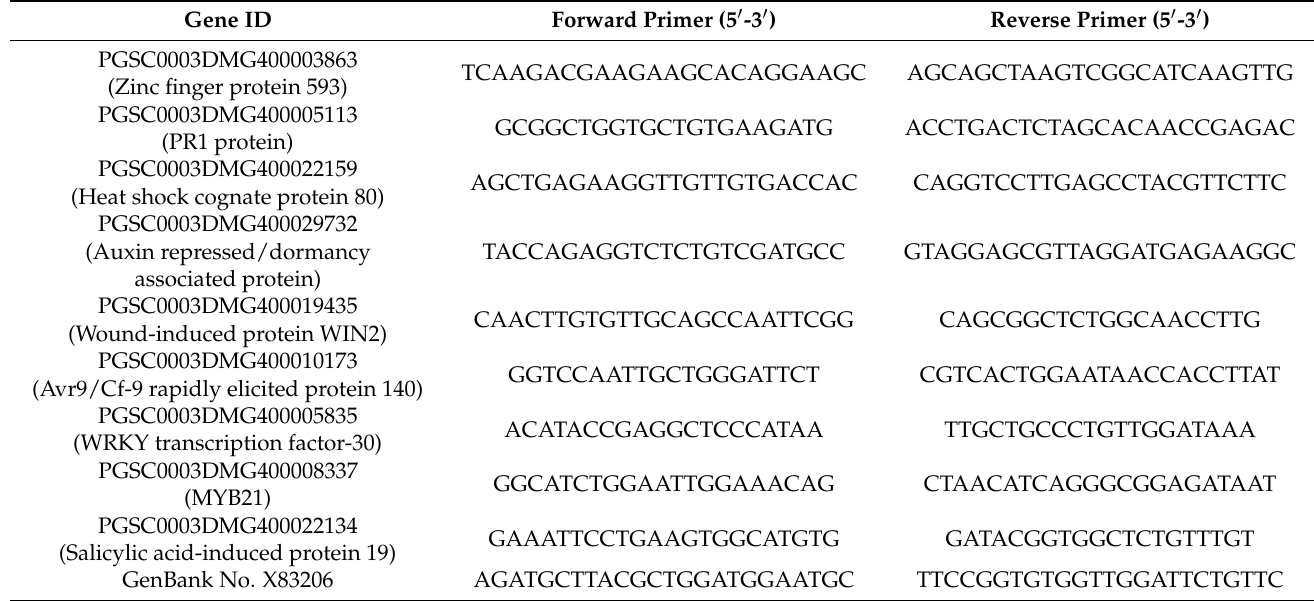
Table 1. Primers used in qRT-PCR analysis in this